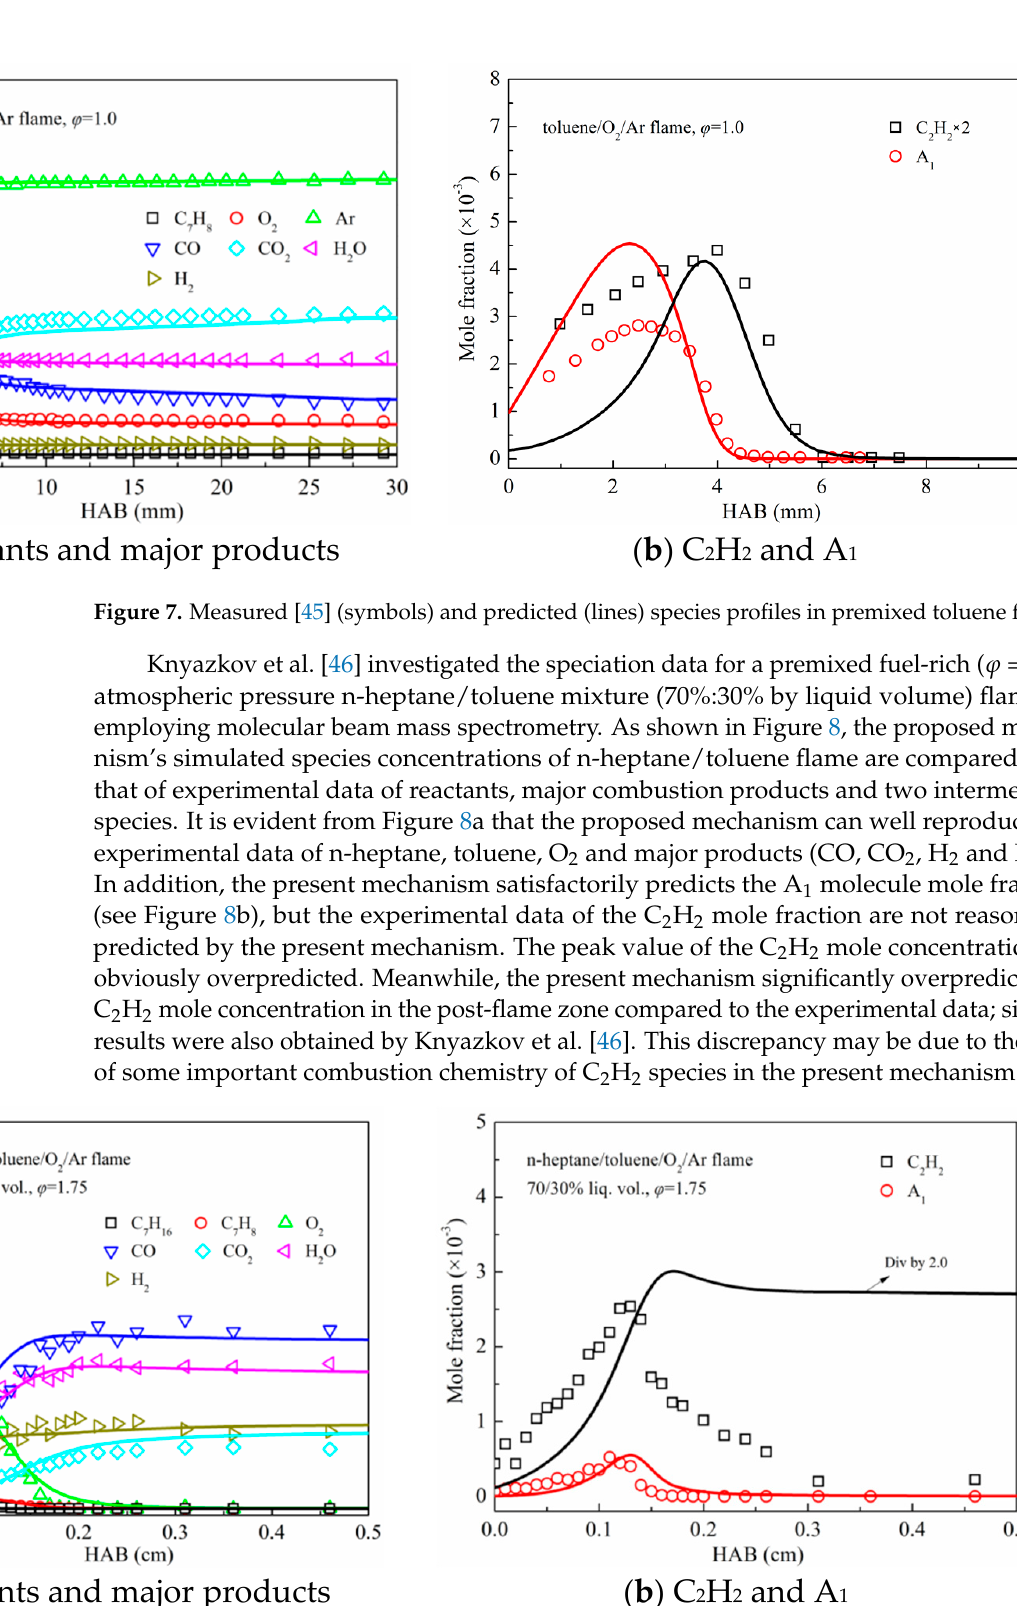
Figure 8. Measured [46] (symbols) and predicted (lines) species profiles in premixed n-heptane/toluene flame. Togb é et al. [47] investigated a premixed fuel-rich ( ϕ = 1.7) DMF/O 2 /Ar flame at low pressure (40 mbar), and the species concentration profiles were detected using